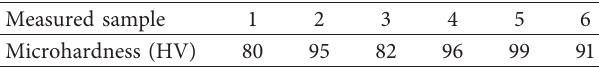
Figure 5: Microstructure images after extrusion: (a) air cooling and (b) water cooling. Table 5: Tensile test results of samples cooled after extrusion. Table 4: Vickers hardness values of samples cooled in air and water after extrusion.